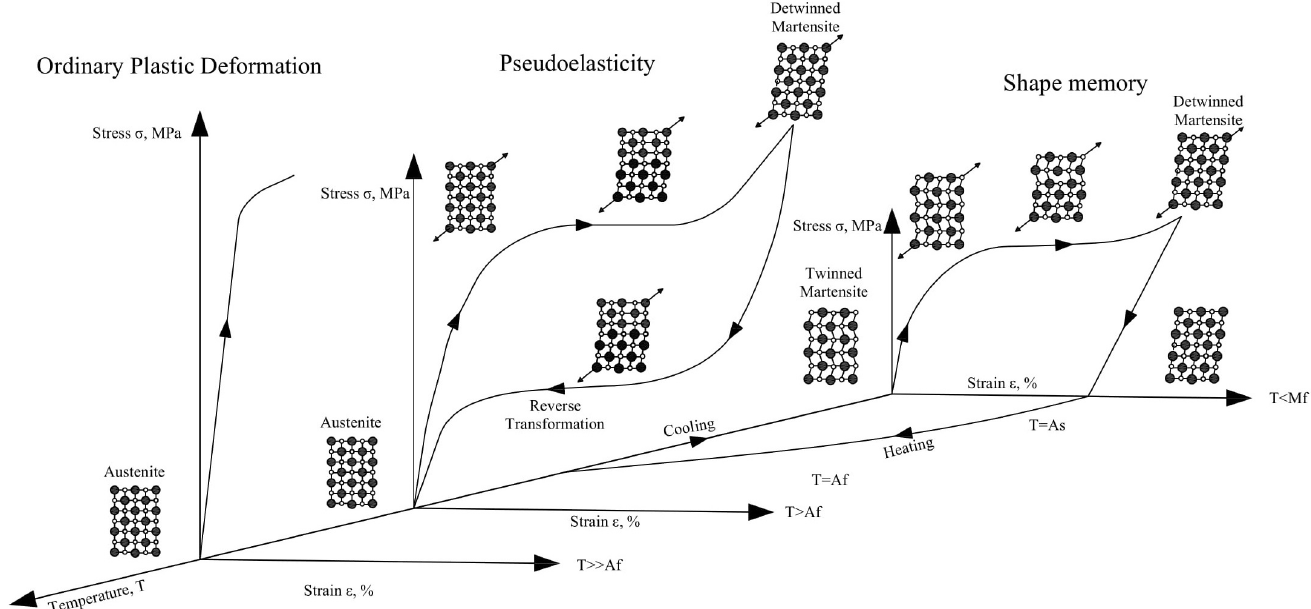
Figure 9. Stress–strain diagram of SMAs and the schematic crystal structures at different temperatures